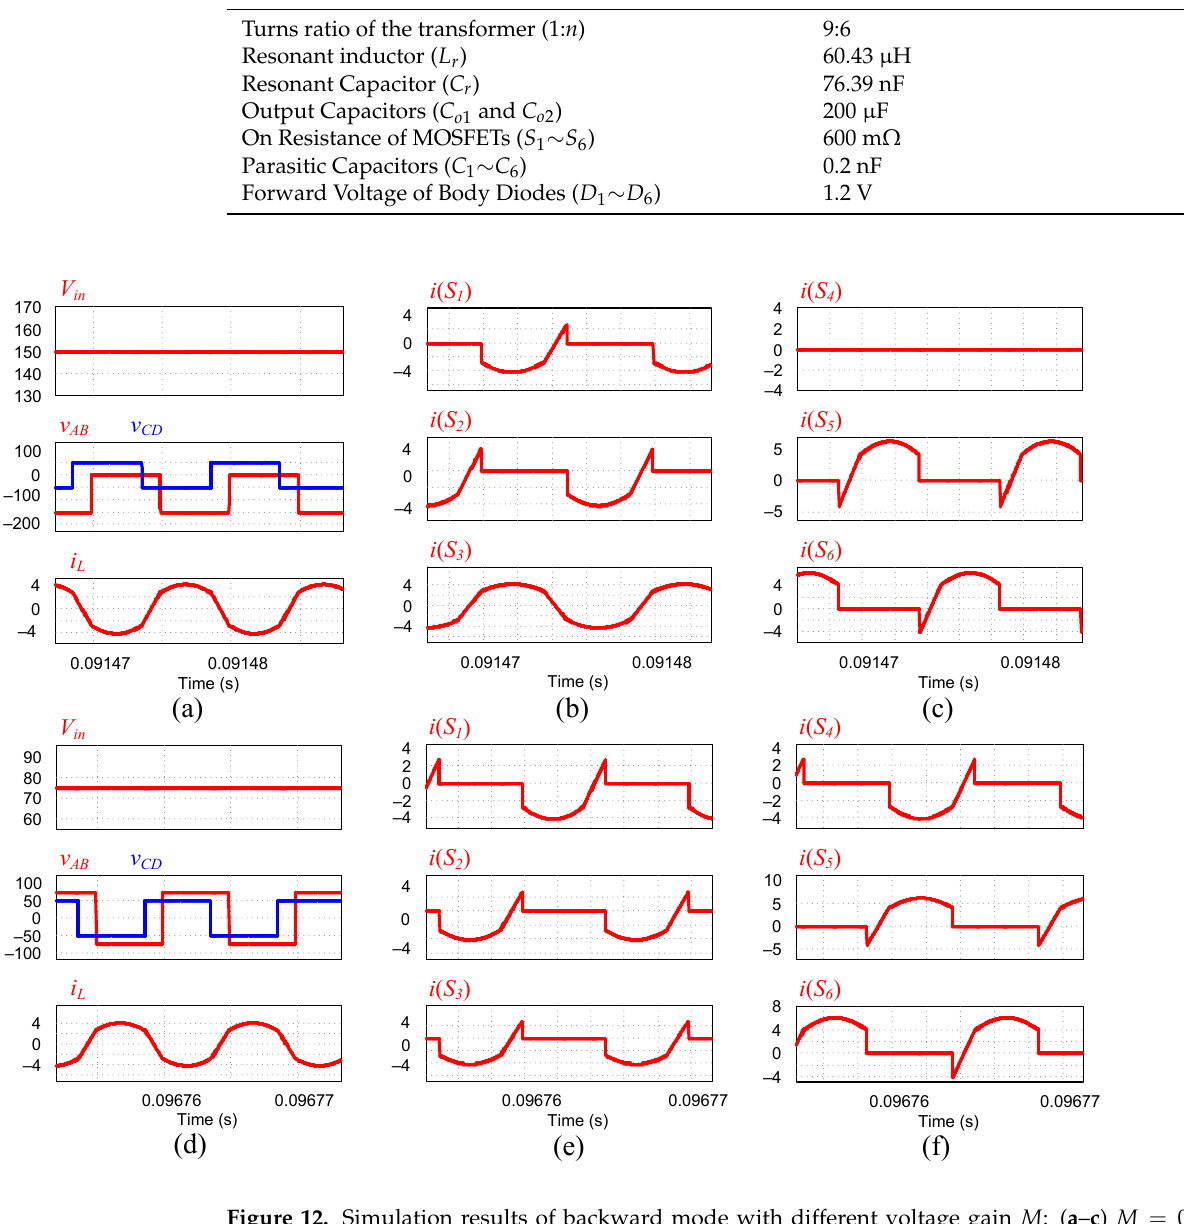
Figure 12. Simulation results of backward mode with different voltage gain M : ( a – c ) M = 0.5; ( d – f ) M =